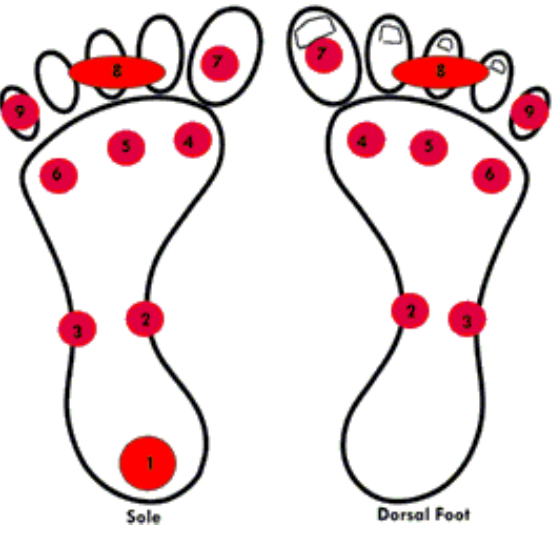
Figure 2. Feet regions where temperature data is collected.